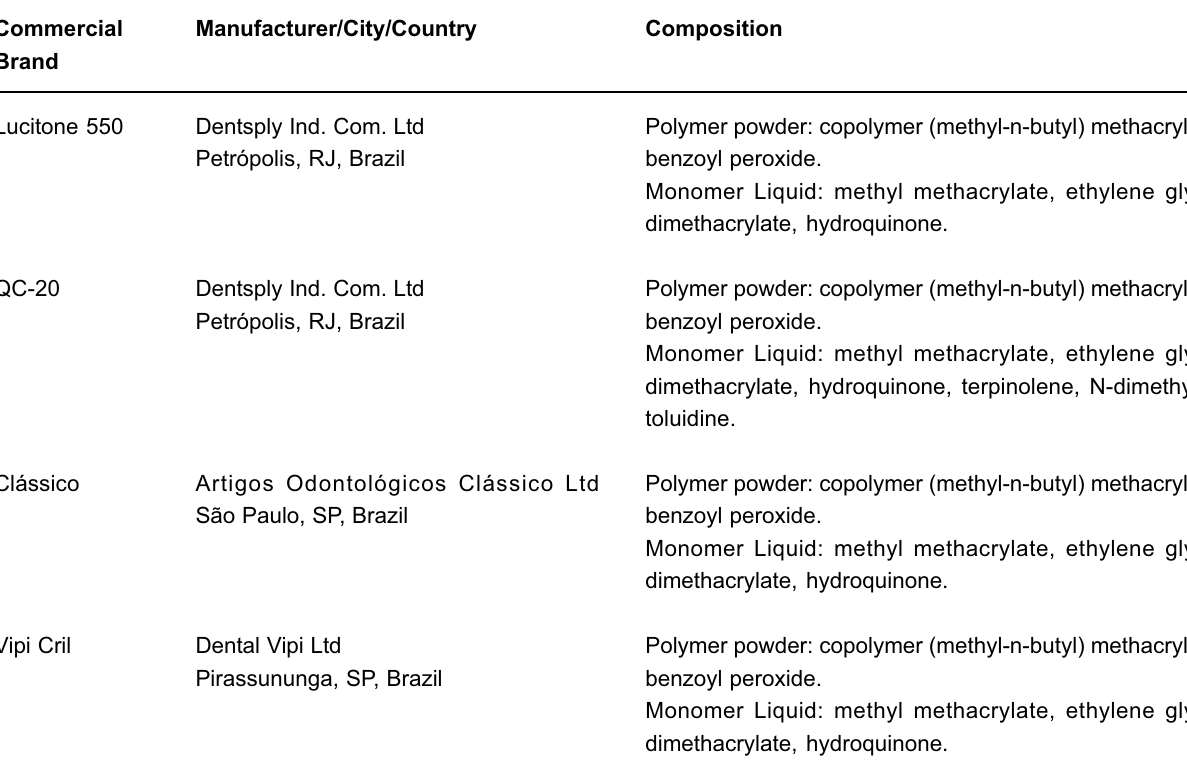
TABLE 1- Specifications of the tested heat-polymerized acrylic